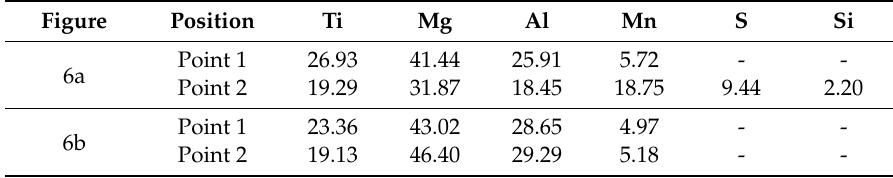
Figure 7. The SEM micrographs and EDS mapping images for the typical oxide in the non-treated sample after etching. ( a ) typical oxide 1. ( b ) typical oxide 2. sample after etching. ( a ) typical oxide 1. ( b ) typical oxide 2. Table 3. EDS point analysis of oxides for the EAM-treated sample after etching shown in Figure 6 Table 4. EDS point analysis of oxides for the non-treated sample after etching shown in Figure 7 (mass (mass percentage).